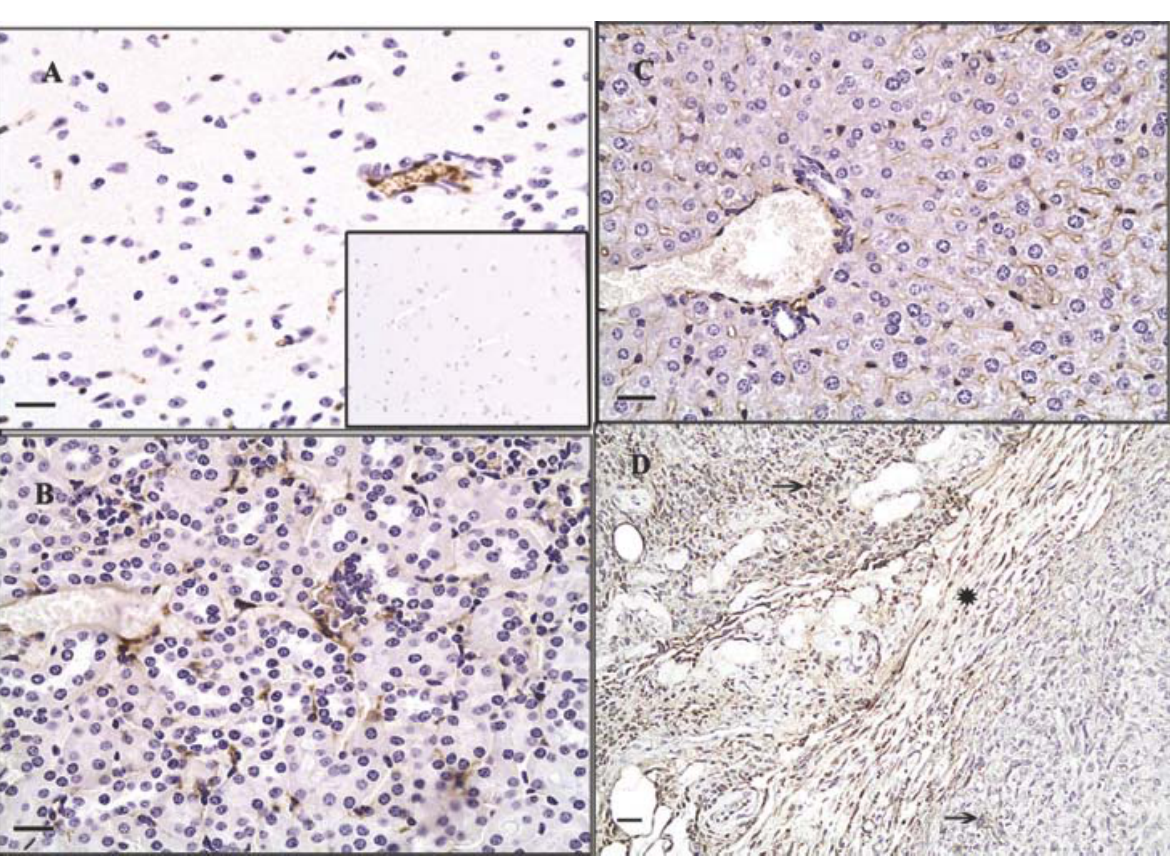
Figure 5. Deposition of immunoglobulin on normal tissue and tumor. Normal tissues ( A-C ) and tissue from a primary murine 4T-1 tumor ( D ) from non-immunized mice. 5 mice per group–one representative mouse- were immunostained with antibody against murine immunoglobulins. Endothelial cells in brain ( A ), kidney ( B ), liver ( C ), and primary tumor ( D ) were labeled with a distribution mirroring that of GS-I binding. IgG is bound to tumor cells (arrows) and stroma (star) in the primary tumor ( D ). 400× magnification, bars equal 20µm. No staining was observed in control sections labeled with antibody against goat immunoglobulin ( inset, A